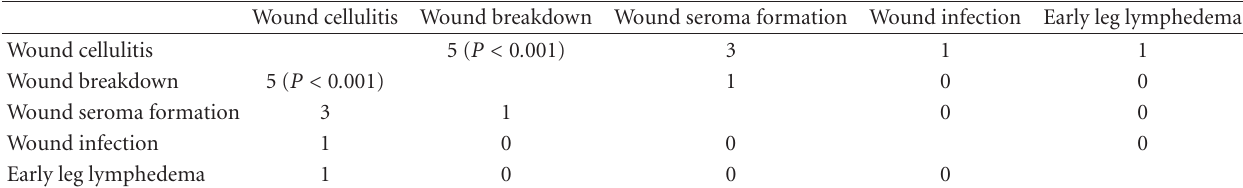
Table 1: Frequency ( n ) of simultaneous complications in the same